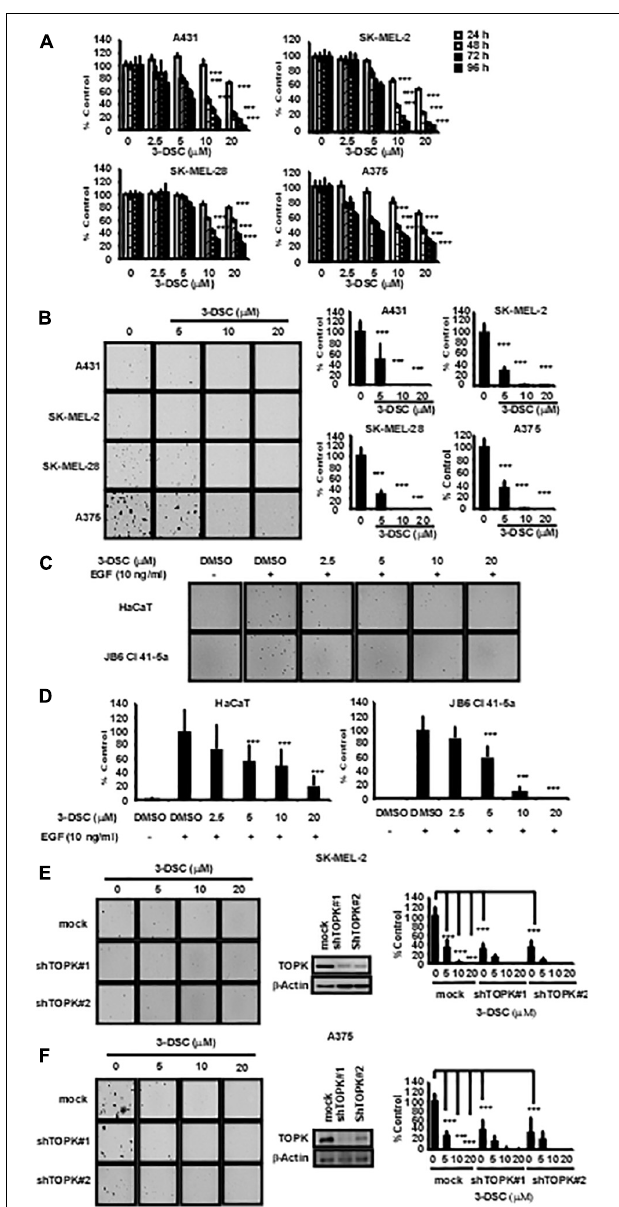
FIGURE 3 | 3-DSC inhibits anchorage-dependent and independent growth in skin cancer cell lines. (A) The inhibition effects of different concentrations of 3-DSC in cell proliferation of A431, SK-MEL-2, SK-MEL-28, and A375 cells. Skin cancer cells were incubated with 3-DSC for 24, 48, 72, and 96 h and growth was detected by MTT assay. Data shown as mean ± SD values. (B) Representative images of anchorage-independent soft agar growth assay using skin cancer cell lines incubated with various concentrations of 3-DSC. (C) Representative images showing the effect of 3-DSC on anchorage-independent growth of EGF-induced transformation of normal skin cells. (D) Quantification of colony numbers shown in panel (C) . Data are shown as mean ± SD values. (E) SK-MEL-2 cell anchorage-independent colony growth after knocking down TOPK and treating with various concentrations of 3-DSC. Colony number is quantified in the right side of the panel. (F) A375 cell anchorage-independent colony growth after knocking down TOPK and treating with various concentrations of 3-DSC. Colony number is quantified in the right side of the panel. *** p <